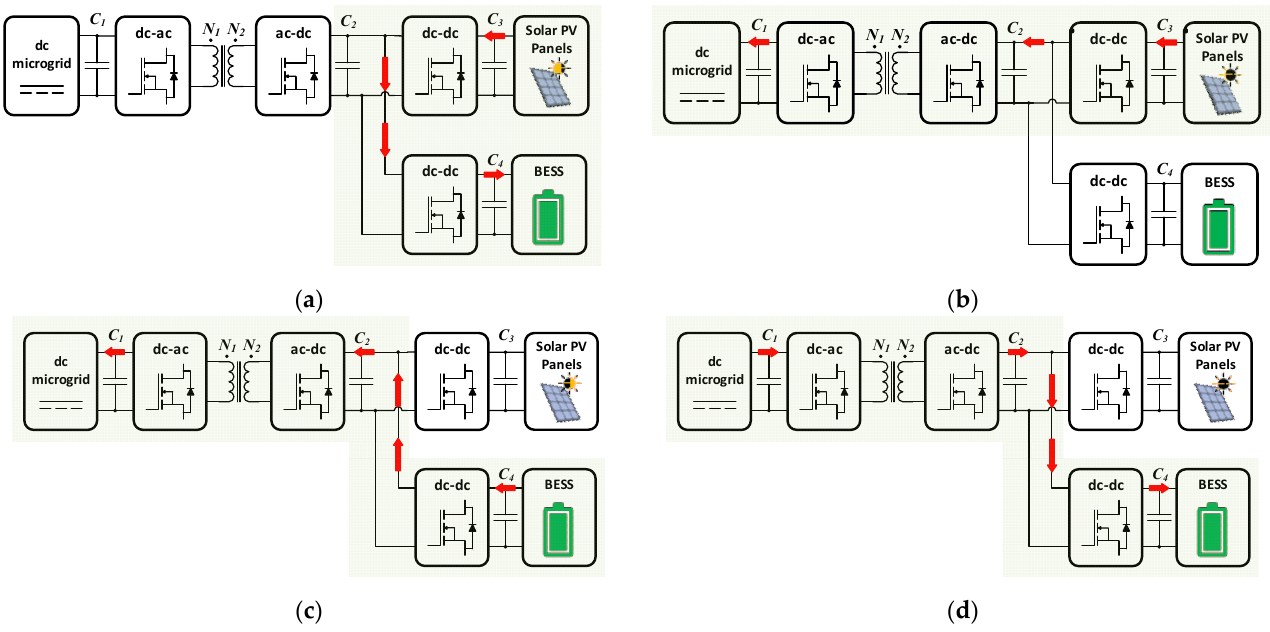
Figure 2. Operation modes for the proposed unified power converter topology: ( a ) solar PV panels to batteries (PV2B); ( b ) solar PV panels to dc grid (PV2G); ( c ) batteries to dc grid (B2G); ( d ) dc grid to batteries